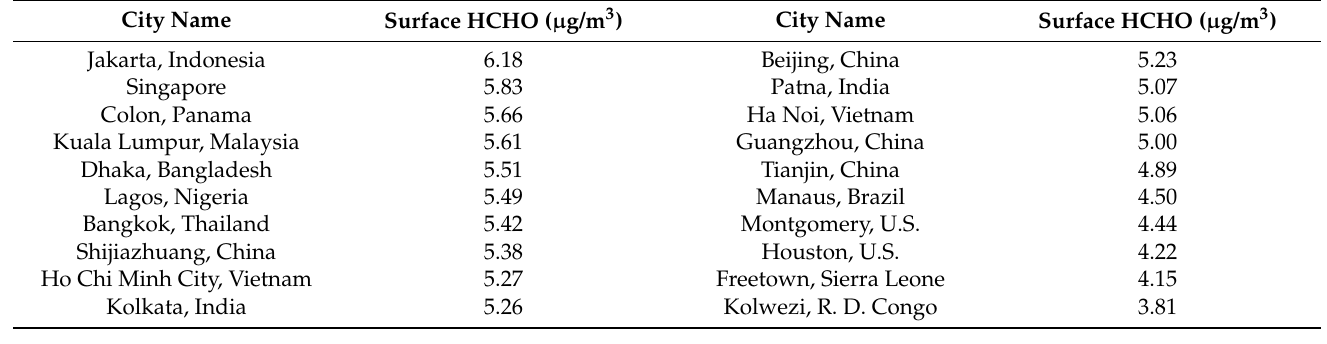
Table 3. Surface HCHO concentration in some typical cities.